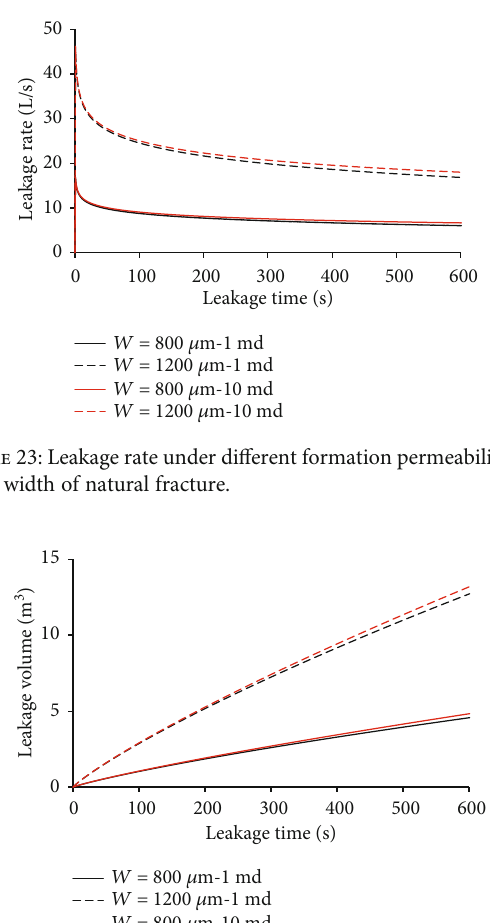
Figure 22: Leakage front distance under di ff erent formation permeability and initial width of natural fracture.